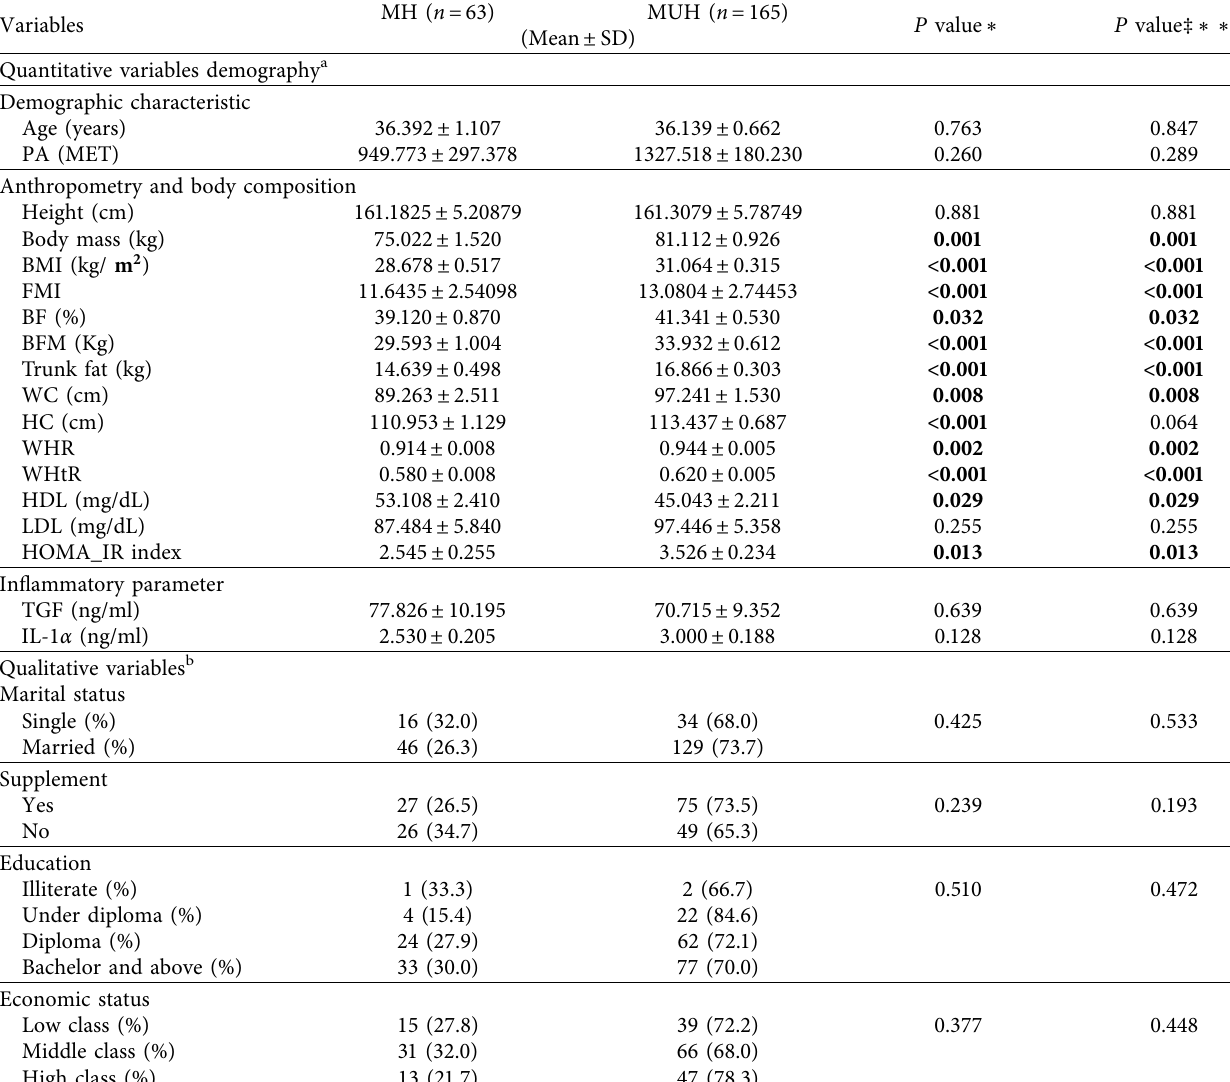
Table 1: Demographic characteristics of MH and MUH overweight and obese women ( N �